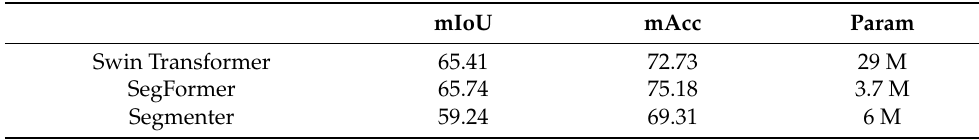
Table 2. Experimental results.